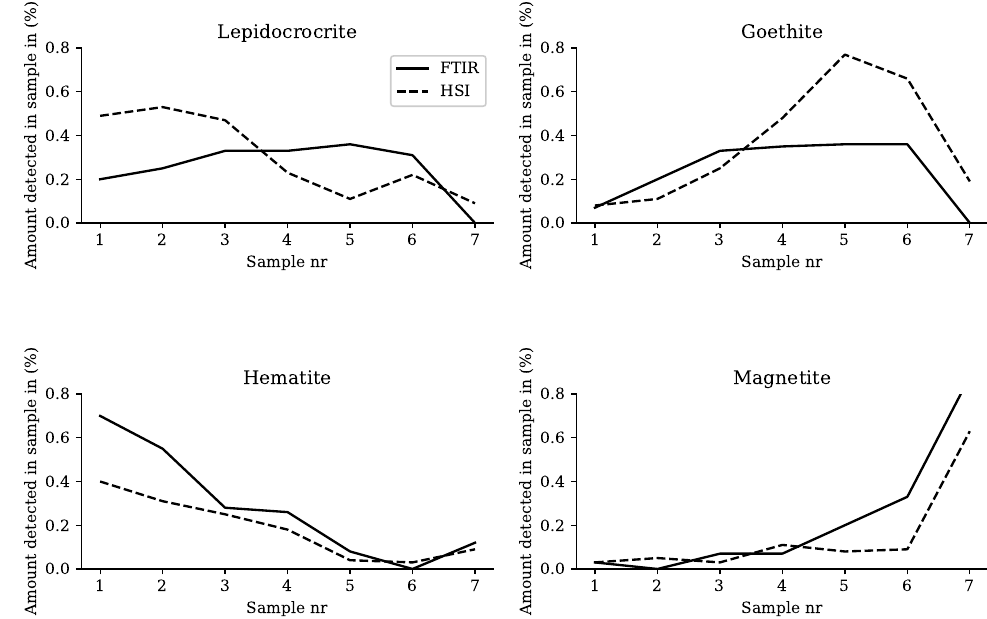
Figure 6. Comparison between the mineral quantities of the FTIR and HSI